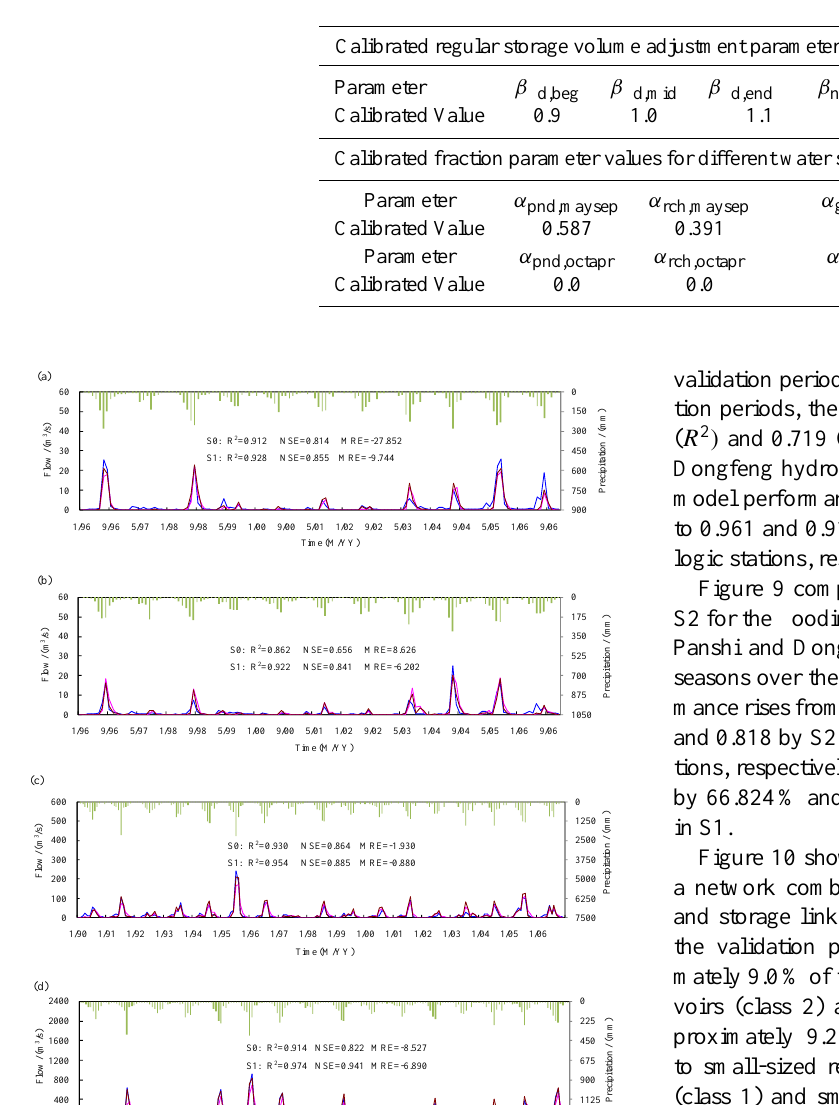
Table 4. Calibrated human interference parameter values, including the regular storage volume adjustment parameters and the fraction parameters for different water sources.